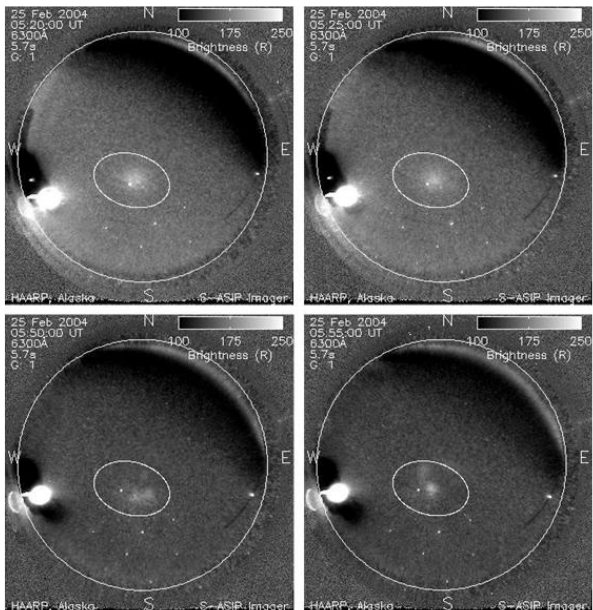
Fig. 2. Example images of the calibrated artificial optical emissions at 630nm from the HAARP all-sky imager. The large circle is the horizon. The smaller oval denotes the HAARP beam − 3dB locus. The bright white disk near the south-west horizon is the moon. The faint arc near the north-east horizon is a natural aurora. The white spots correspond to stars. The top two panels show images from pumping close to the second gyro-harmonic. The bottom two pan- els show images from pumping just above the ionospheric critical